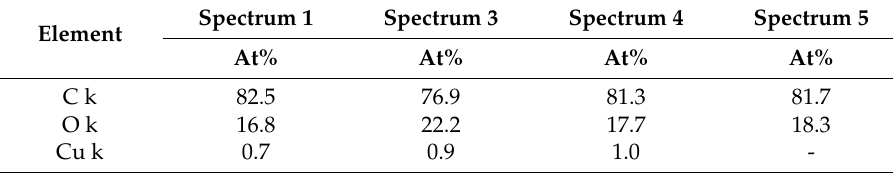
Table 5. Detected elements in the surface with Cu NWs at 10.0% w / w